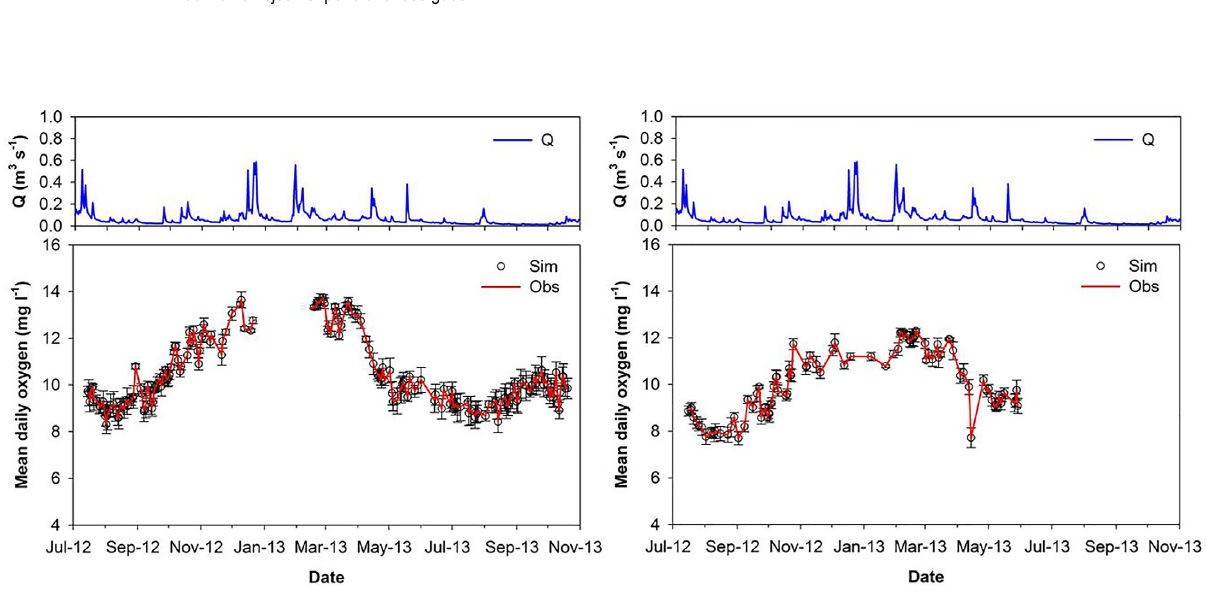
Fig 4. Discharge for the study period (top) with measured daily DO time-series compared to daily modelled DO with the daily RMSE as error bars. Lower catchment left, and upper catchment right.